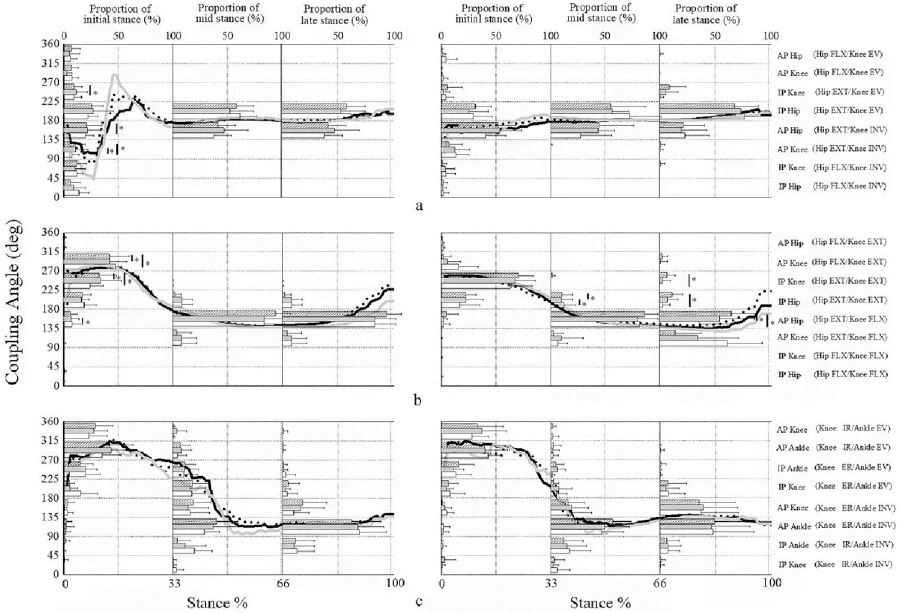
Fig 2. Mean coupling angle during slow 10%, normal and fast 10% running cadence. Mean coupling angle for all subjects across stance phase for hip sagittal versus knee frontal (a), hip sagittal versus knee sagittal (b) and knee transverse versus ankle frontal (c) couples in RFS (left column) and FFS (right column) during slow10% (grey line), normal (dash line) and fast10% (black line) running cadence. Each figure is divided into three parts, which represent the distribution proportion of slow10% (white), normal (grey) and fast10% (slash) in each coordination pattern during initial (left column), mid (middle column) and late (left column) stance phases. � indicates a significant difference between groups (p <